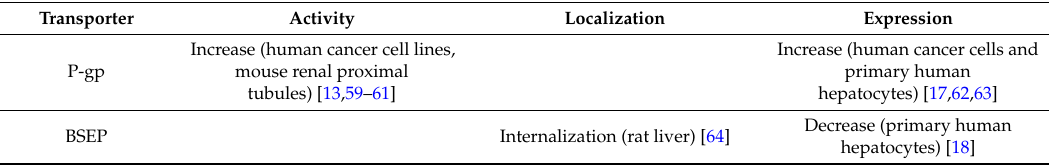
Table 3. Main effects of the reference protein kinase C (PKC) activator phorbol-12-myristate-13-acetate (PMA) on drug transporter activity, localization and/or expression. P-gp: P-glycoprotein; BSEP: bile salt export pump; MRP: multidrug resistance-associated protein; BCRP: breast cancer resistance protein; OATP: organic anion transporting polypeptide; OAT: organic anion transporter; NTCP: sodium-taurocholate co-transporting polypeptide; OCT: organic cation transporter; OCTN: